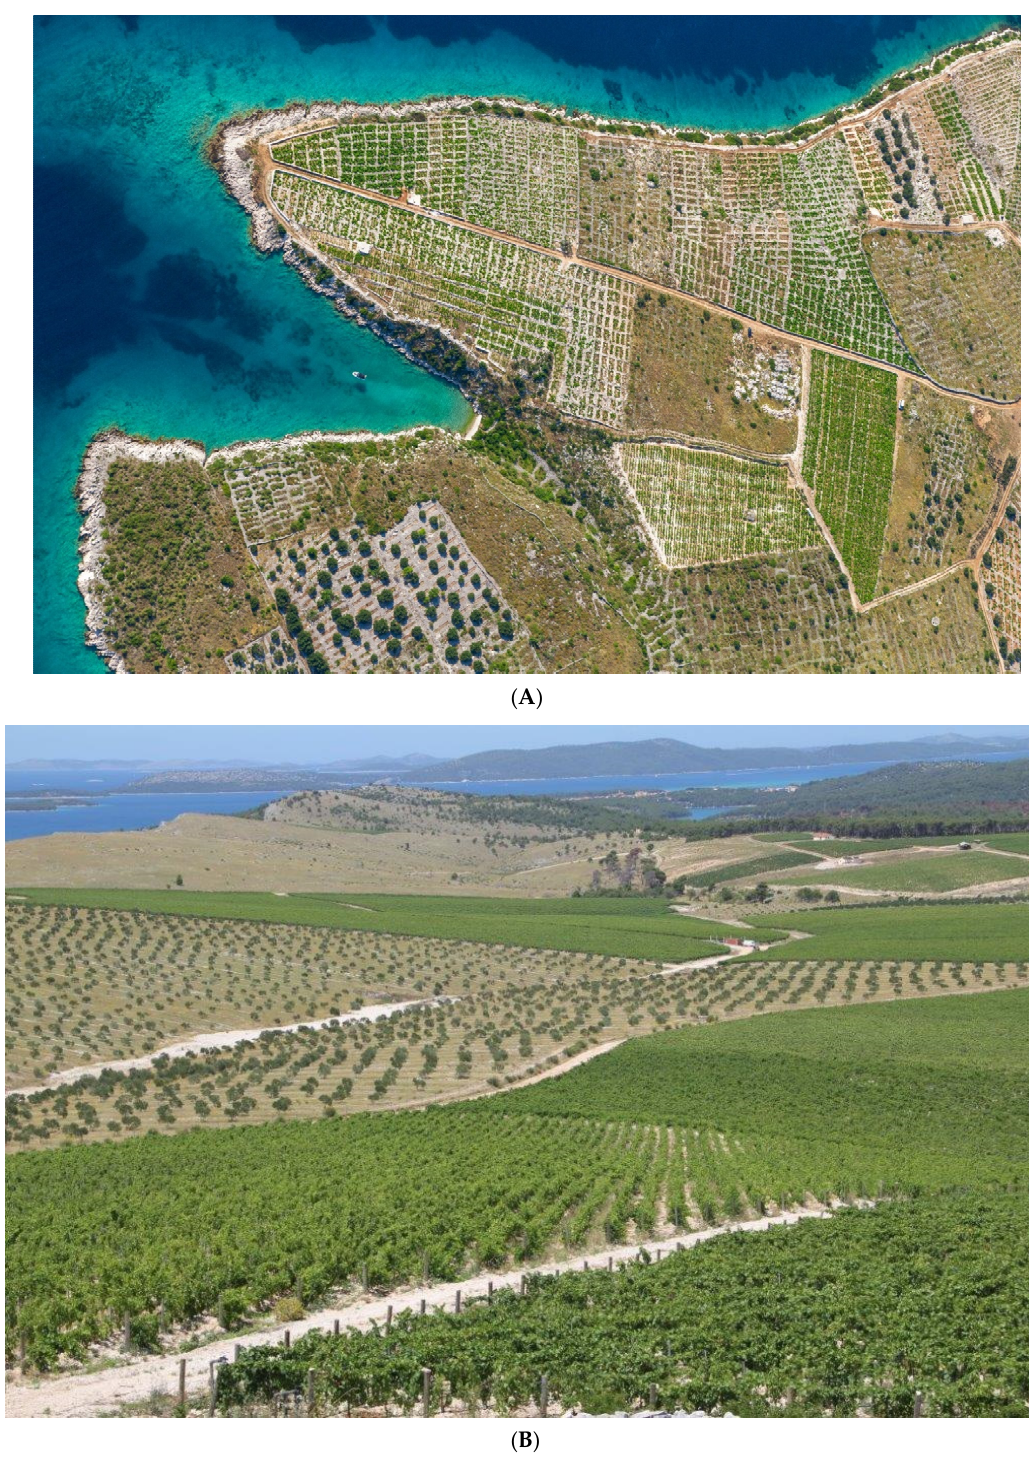
Figure 5. Photographs of A . Vineyards and olives plantations on karst steep slopes within stony walls (Location Primošten); B . Grapevine and olives plantations on karst plateau reclaimed by stone crushing (Location Jadrtovac, Šibenik).